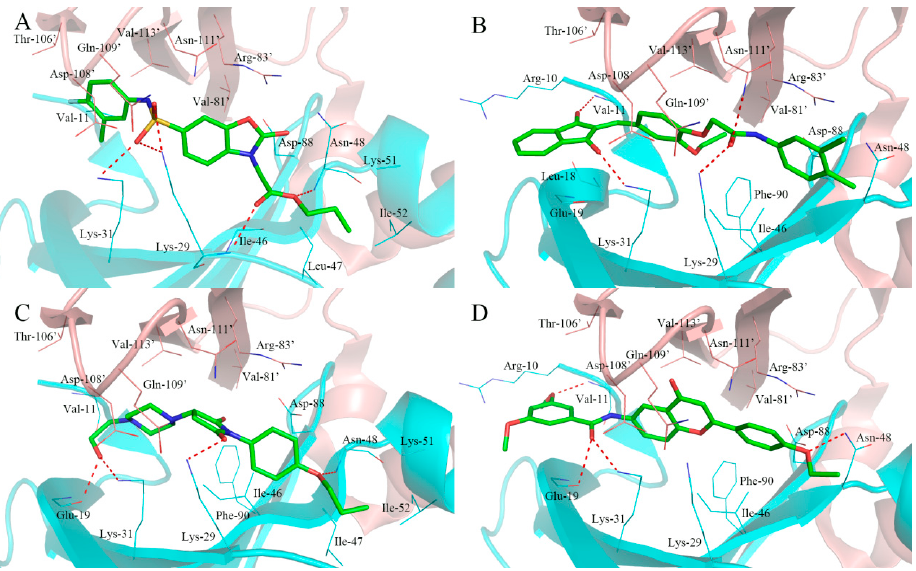
Figure 6. The binding modes of typical hit compounds for α 1 β 1 γ 1 AMPK isoform. ( A ): F064-1335; ( B ): M5653-1884; ( C ): M8006-4303; ( D ): F264-0391. The α subunit was shown in cartoon and colored by cyan and the β subunit was shown in cartoon and colored by pink. The hydrogen bonds were labeled with red dashed lines.